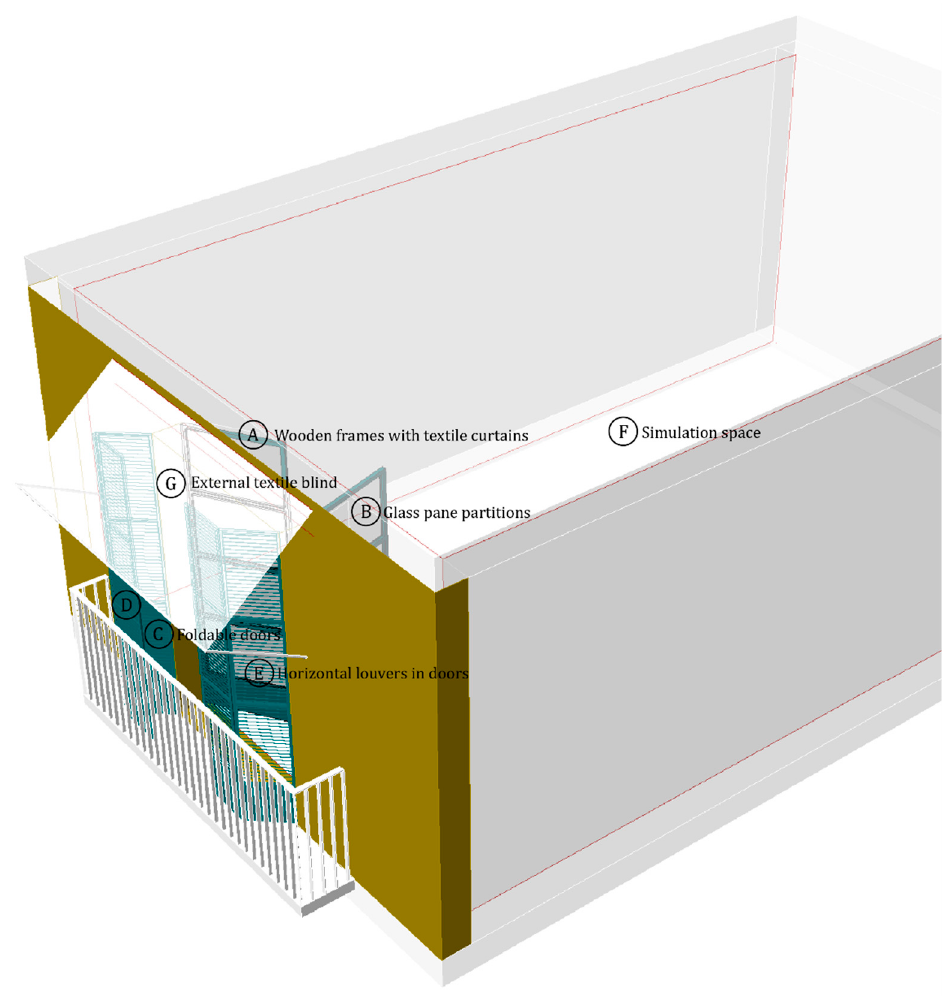
Figure 1. Perspective view of the parametric model including thermal and optimization simulations to search possible and suggested compositions of the multi-layered building envelope. The red line indicates the thermal zone simulated.